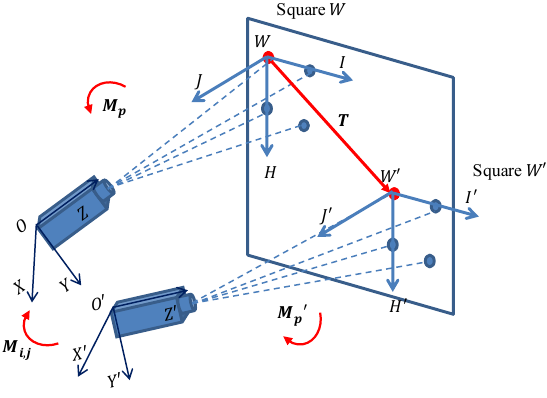
Figure 8. Calibration of transformation matrix between